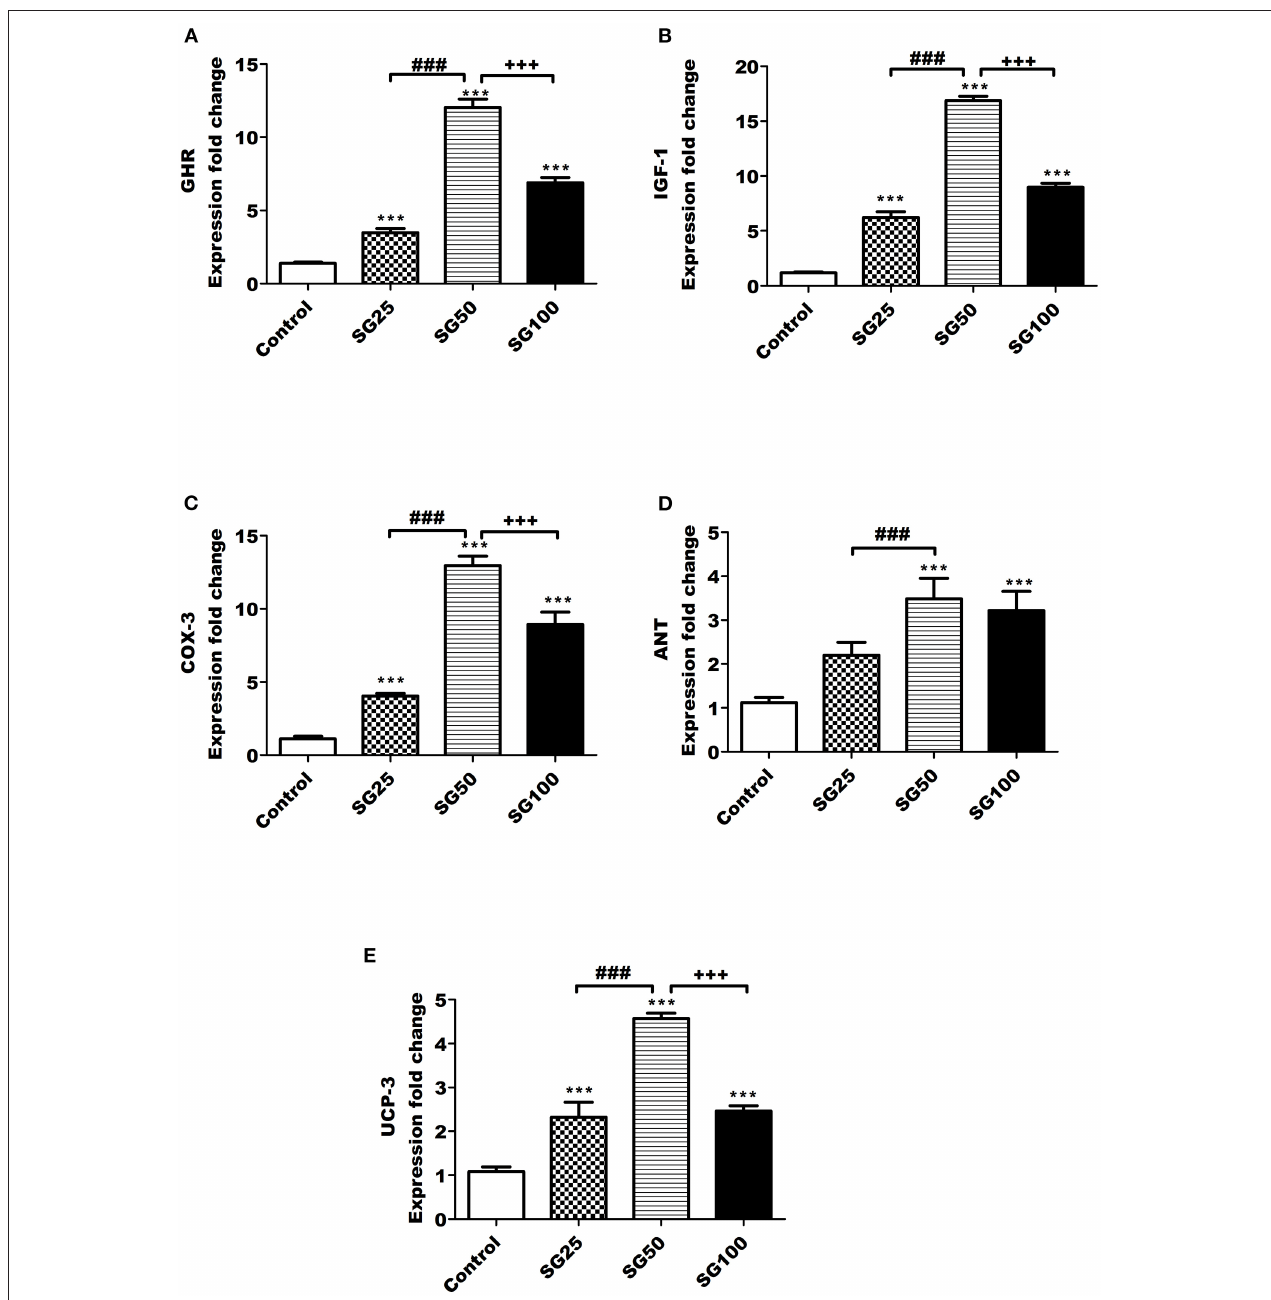
FIGURE 1 | Real-time PCR ( RT-PCR) validation of the growth hormone receptor (GHR) (A) , insulin-like growth factor 1 ( IGF-1 ) (B) , cyclooxygenase 3 ( COX-3) (C) , adenine nucleotide translocase adenine nucleotide translocase (ANT) (D) , and uncoupling protein 3 ( UCP-3) (E) genes. *** p < 0.001 vs. control. ### p < 0.001 vs. SG25. +++ p < 0.001 vs. SG100, SG25, birds fed 25 ppm. SG50, birds fed 50 ppm. SG100, birds fed 100 ppm Sangrovit ®